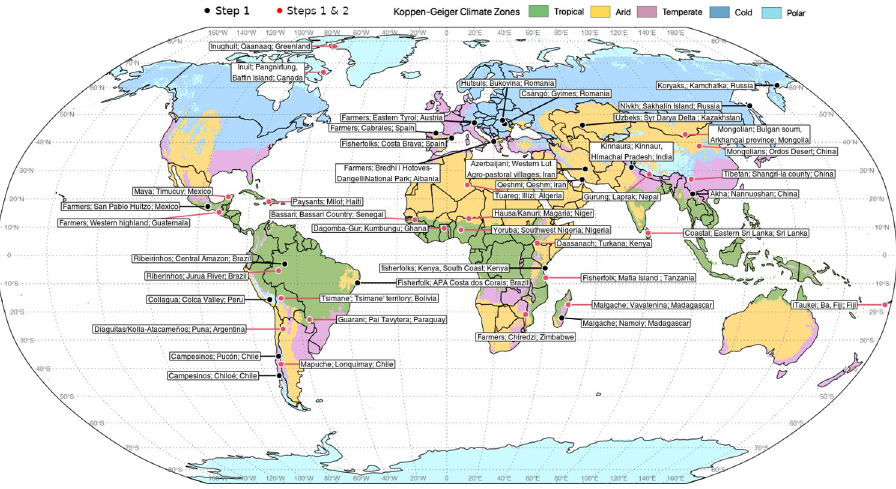
Fig 2. Selected study sites. Sites are displayed across the main different climate types defined by Koeppen-Geiger [22]. Figure elaborated by the authors. Original map from the Natural Earth data set in the public domain (available from https://www.naturalearthdata.com), elaborated with the R libraries maptools [23] and sp [24].